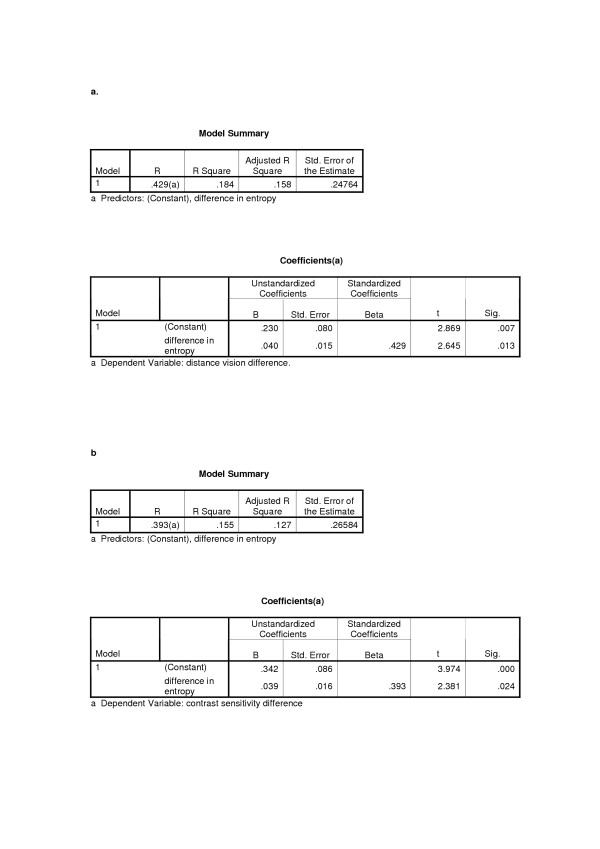
Improvements in vision compared to improvements in AA score, after capsulotomy; a. Regression of distance vision improvement against improvement in AA score, b. Regression analysis of contrast sensitivity improvement against improvement in AA score